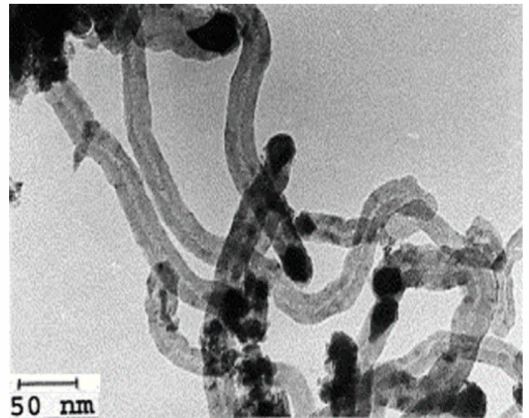
Figure 3. TEM image of spent Co/Al 2 O 3 catalyst; reprinted with permission from ref. [39]. Copyright 1999